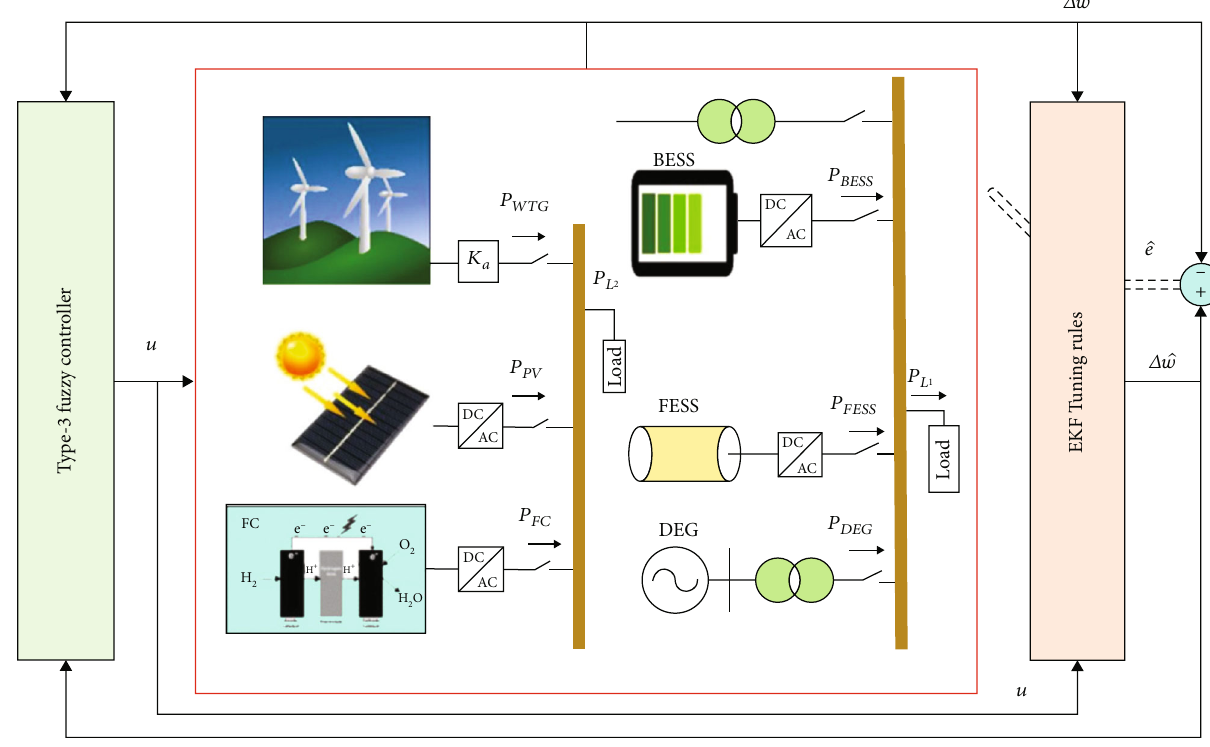
Figure 1: General